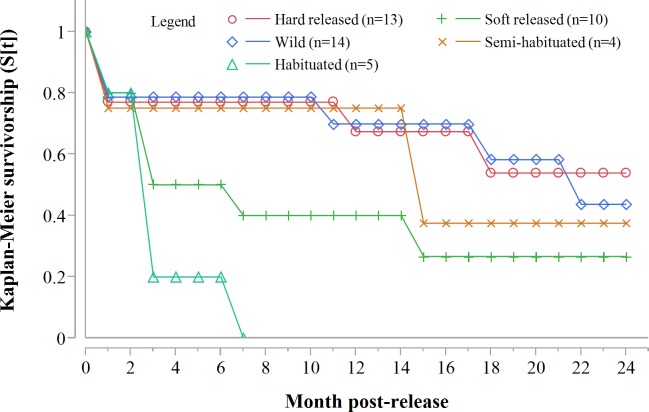
Progressive Kaplan-Meier survivorship estimates for translocated cheetahs by degree of habituation and release mode.Data standardised to month post-release.